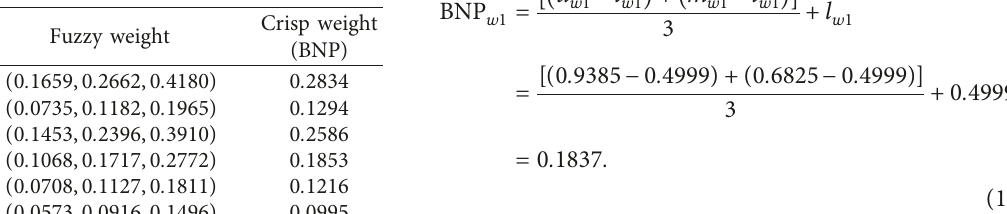
Table 4: The weight of the input variables with respect to the variable group ( V 1 ).